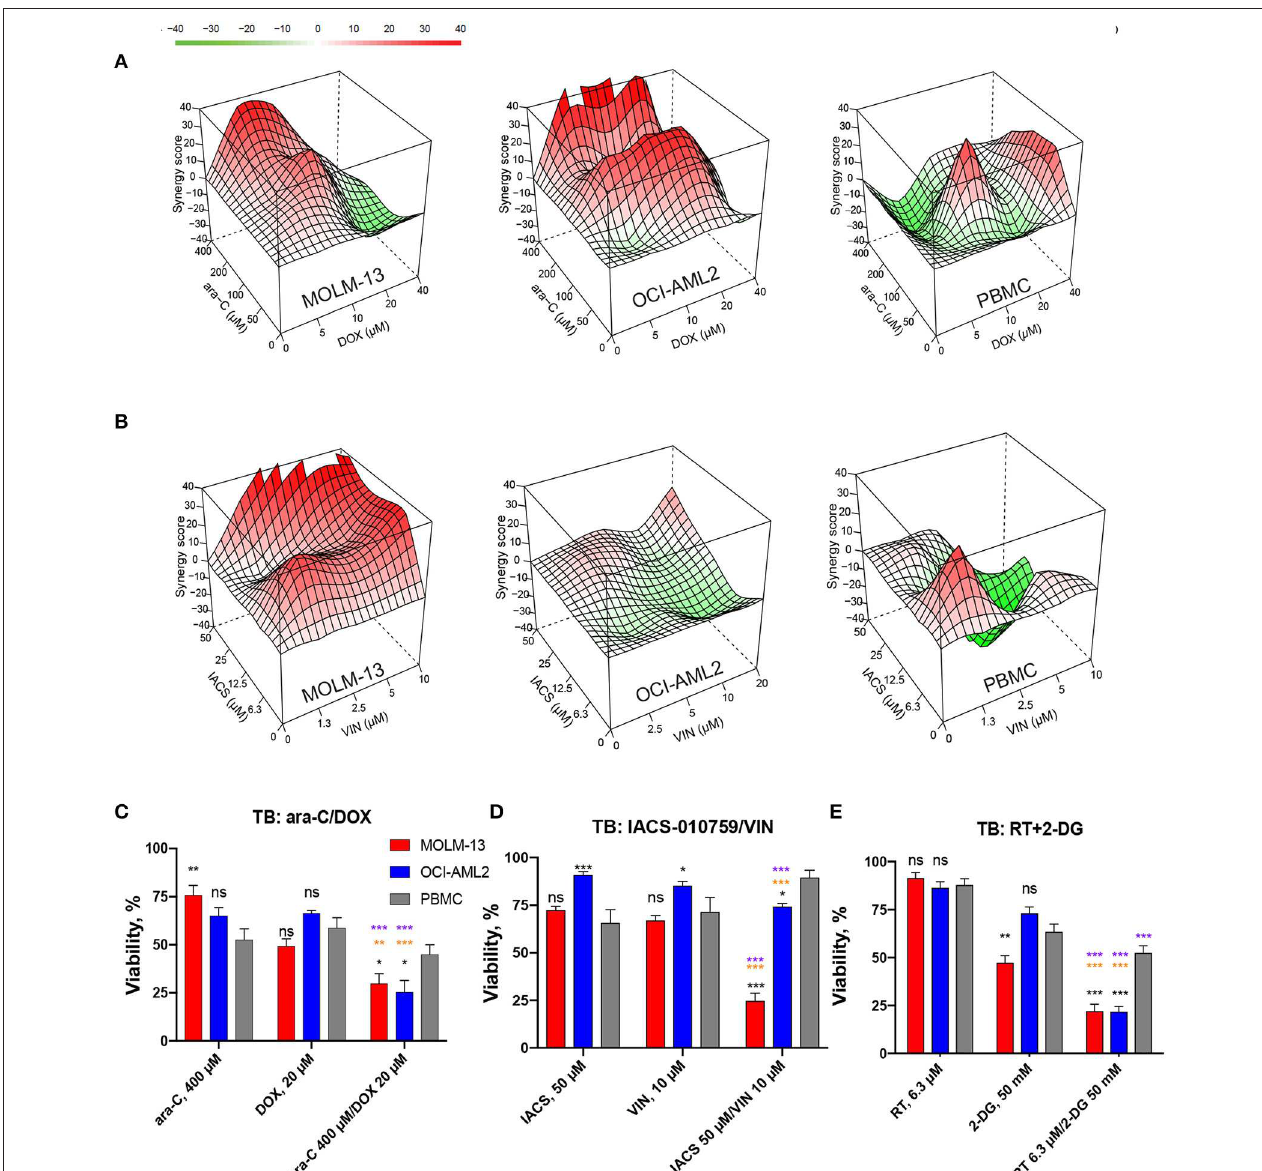
FIGURE 5 | Comparison of cytotoxic effect and selectivity of IACS-010759/vinorelbine and rotenone/2-deoxy-D-glucose drug pairs with cytarabine/doxorubicin by trypan blue exclusion. (A,B) Drug combination landscapes for AML cell lines or PBMCs were built using Bioconductor package “synergyfinder.” One representative replicate (with maximal synergy closest to its average value) is shown: (A) cytarabine/doxorubicin, (B) IACS-010759/vinorelbine. (C–E) Survival of MOLM-13, OCI-AML2, or healthy PBMCs following single or combinatorial treatments with doses of maximal selectivity: (C) cytarabine/doxorubicin, (D) IACS-010759/vinorelbine, (E) rotenone/2-deoxy-D-glucose. Shown are mean ± SEM from three independent biological replicates. Significance of changes in survival were assessed via Student’s t -test. *** p < 0.001; ** p < 0.01; * p < 0.05; ns: p > 0.05. Black stars or ns indicate comparison of AML cells vs. healthy PBMCs under the same treatment condition; purple stars indicate significantly lower survival under combinatorial treatment compared to single mitocan for each cell line; orange stars indicate significantly lower survival under combinatorial treatment compared to single complementary drug for each cell line.